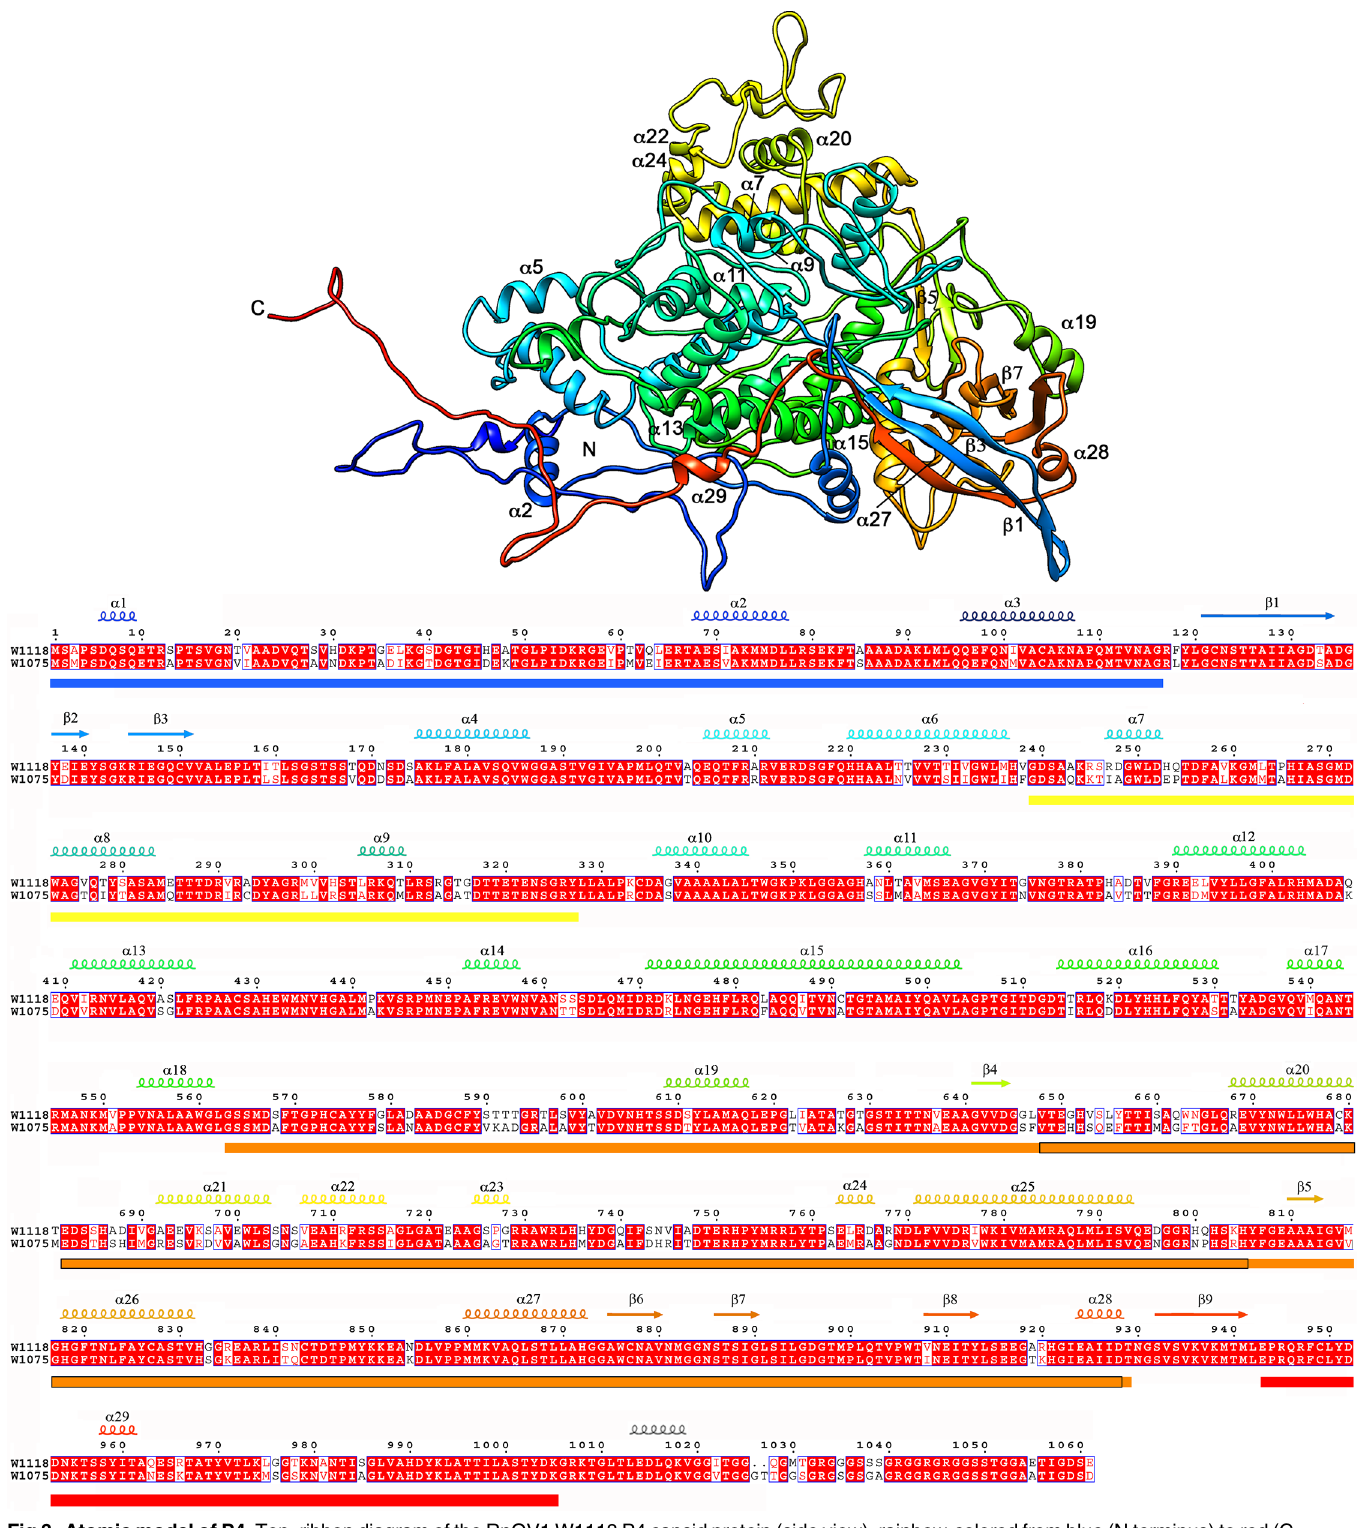
Fig 3. Atomic model of P4. Top, ribbondiagramof the RnQV1 W1118 P4 capsid protein (side view), rainbow-colored from blue (N terminus) to red (C terminus). The N and C termini are indicated.Bottom, sequenceand SSE analysisof the 1059-residue P4, rainbow-colored from blue (N terminus) to red (C terminus). The C-terminal 54-residuesegment is not visible; the consensus-predictedSSE for P2 (black) is shown. Coloredboxes indicateinsertionsin the